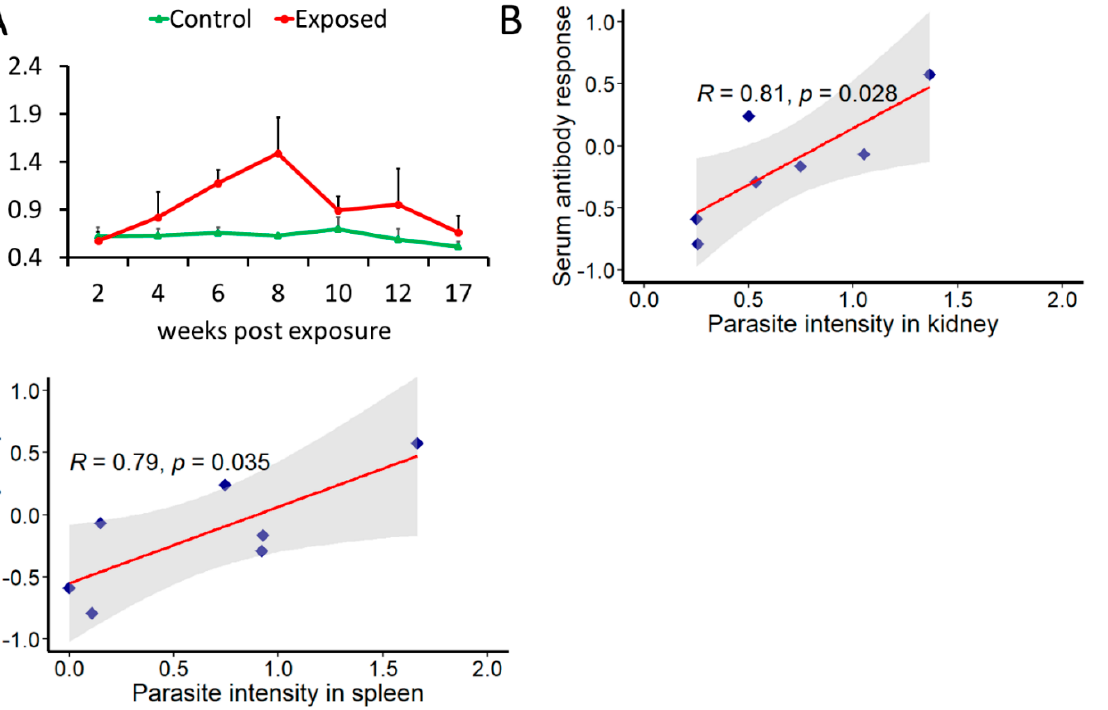
Figure 3. Determination of anti- T. bryosalmonae antibody and its correlation with parasite intensity. The mean values of antibody levels and parasite intensity in infected brown trout ( n = 6) were log2 transformed ( A ) Kinetics of anti- T. bryosalmonae antibody in brown trout using indirect ELISA at different time points; ( B ) correlation between serum antibody levels and parasite intensity in kidney; ( C ) correlation between serum antibody levels and parasite intensity in spleen. For correlation plots, values on x and y axes are log2 transformed. Pearson product-moment correlation coefficient (R) was calculated and statistical significance was tested at p = 0.05. Shaded region represents 95% confidence intervals.